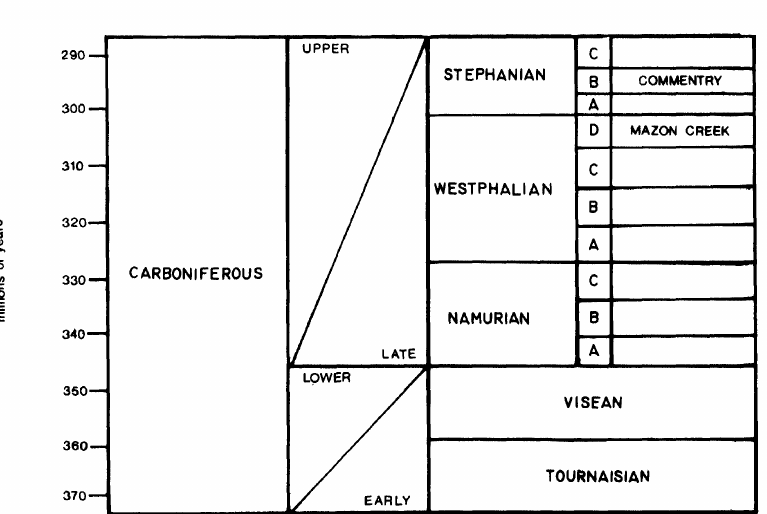
Fig. I. Geological Time Table of the Carboniferous. Note the different ages of the Commentry and Mazon Creek